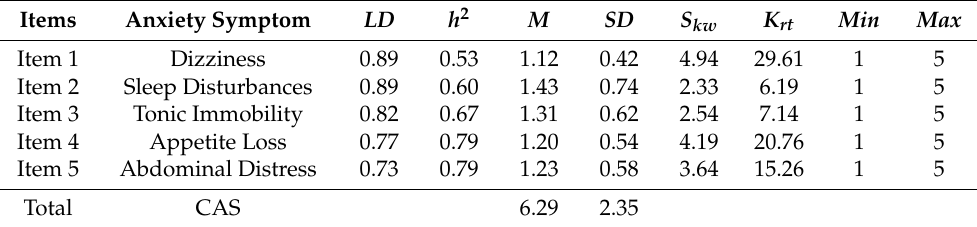
Table 1. CAS EFA